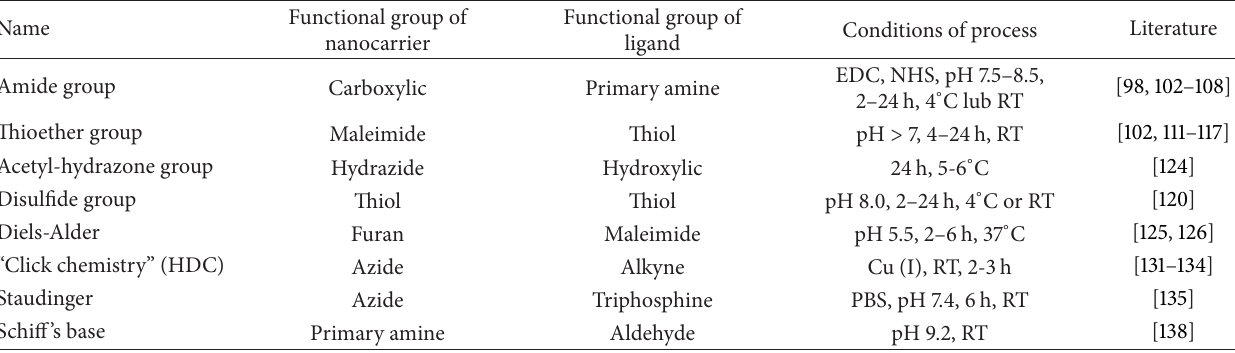
Table 1: Types of covalent ligand-carrier bindings.